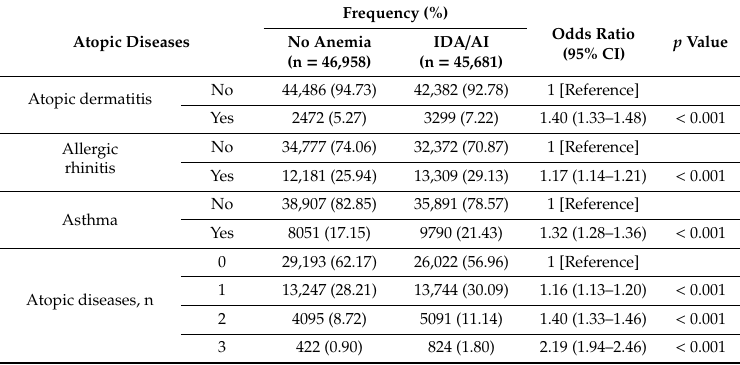
Table 2. Association between atopic diseases and anemia.